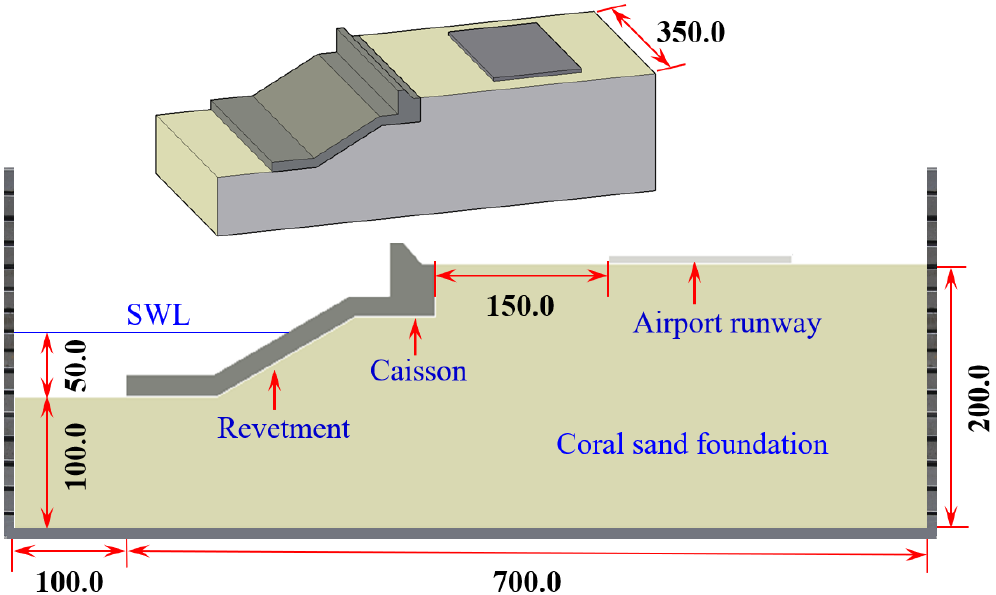
Figure 2. Schematic map of the physical model and the dimensions at model scale (Unit: mm). In practical engineering, the revetment breakwater and runway are both built with reinforced concrete, and the overall density is about 𝜌 = 2500 kg/m 3 . In the physical model, aluminum alloy material ( 𝜌 = 2800 kg/m 3 ) is used to simulate the breakwater and runway. To make the overall density of the breakwater and runway meet the requirement of similarity with the prototype model, the breakwater and runway are partially hollowed out during the model preparation, ensuring that the overall density of the breakwater and